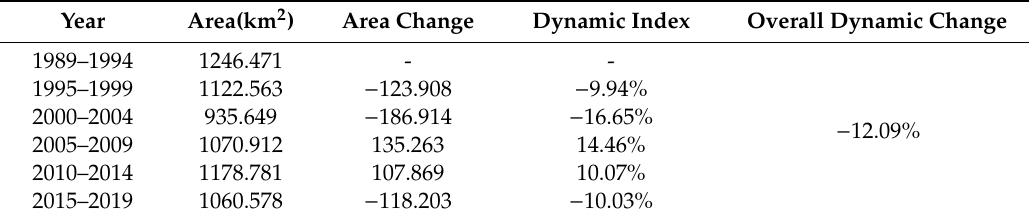
Table 3. The dynamic attitude of the maximum water body area from 1989 to 2019.